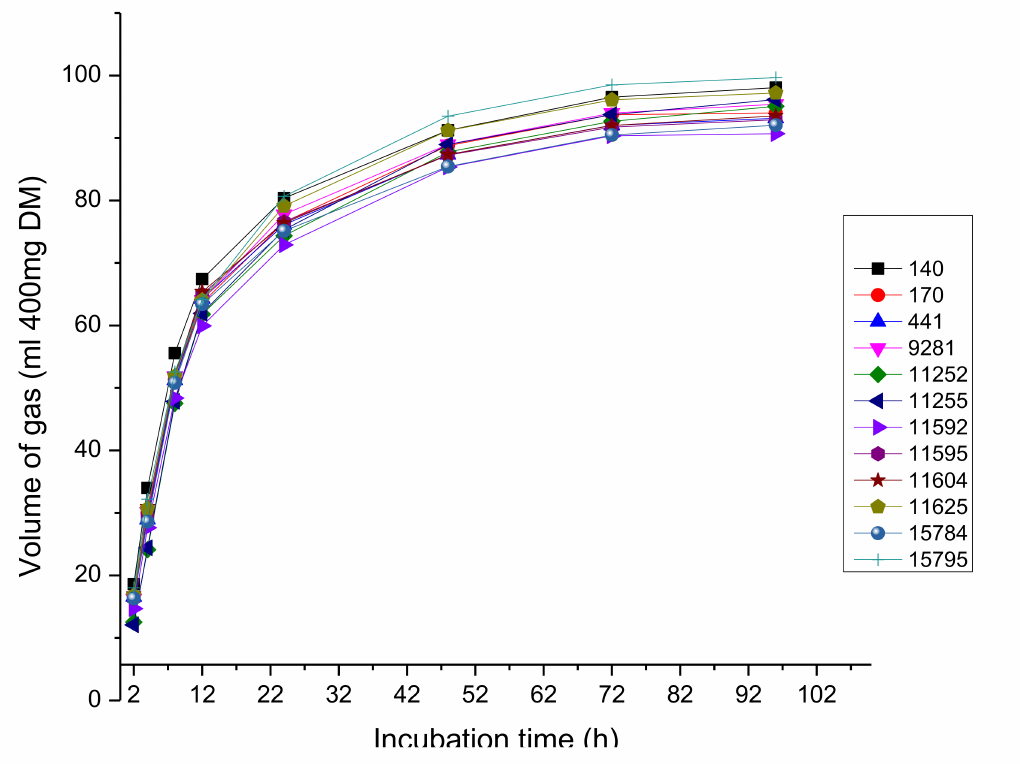
Figure 4. Trend of gas production pattern for di ff erent forages of S. scabra accessions incubated with rumen fluid in